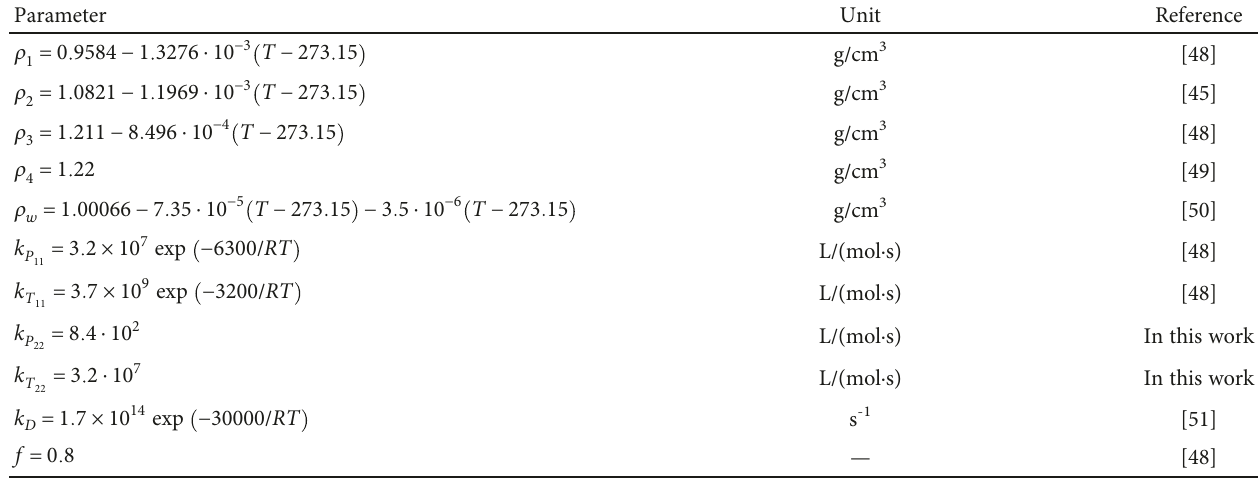
Table 2: Model parameters used for simulation of vinyl acetate/acrylic acid system.